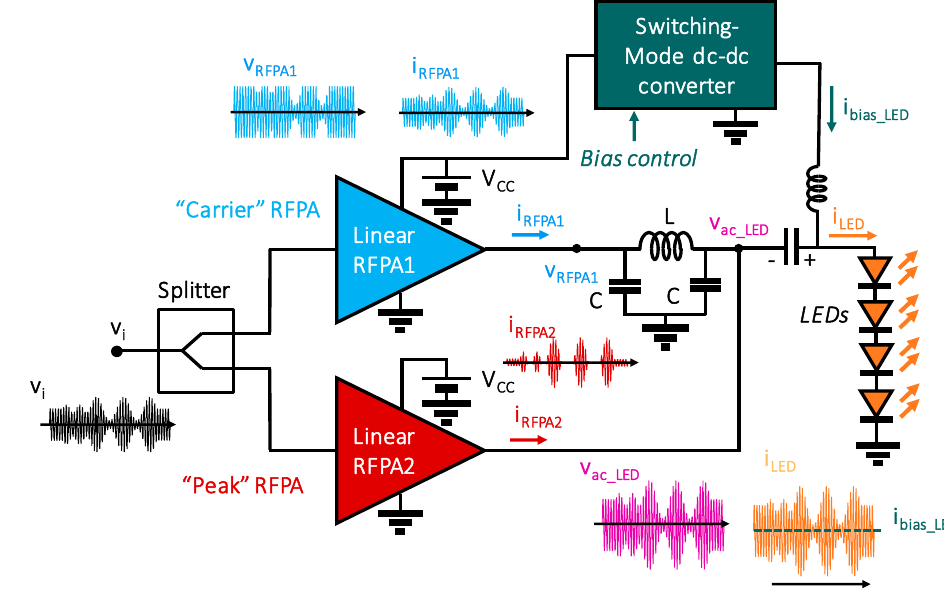
Figure 5. Appling the Doherty technique to a VLC-LED driver. This scheme is only valid for narrowband approaches.